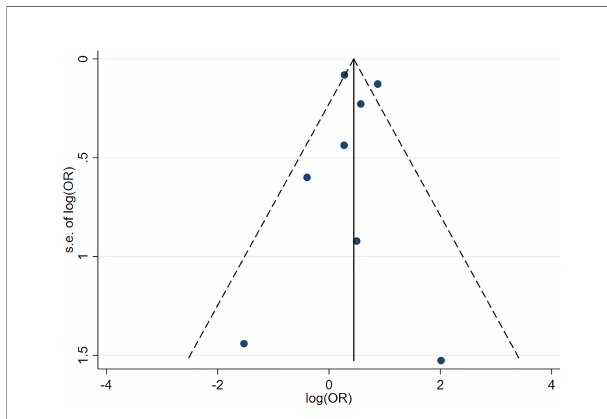
FIGURE 5 | Funnel plot of the meta-analysis of risk of Parkinson ’ s disease in patients